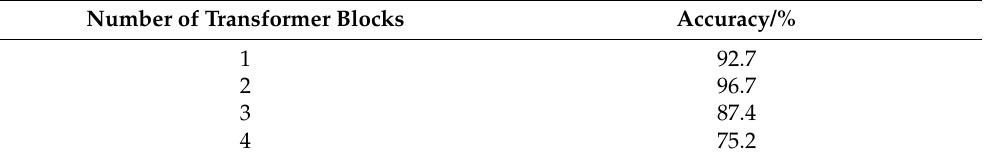
Table 7. Effect of the number of mesh transformer blocks on the classification